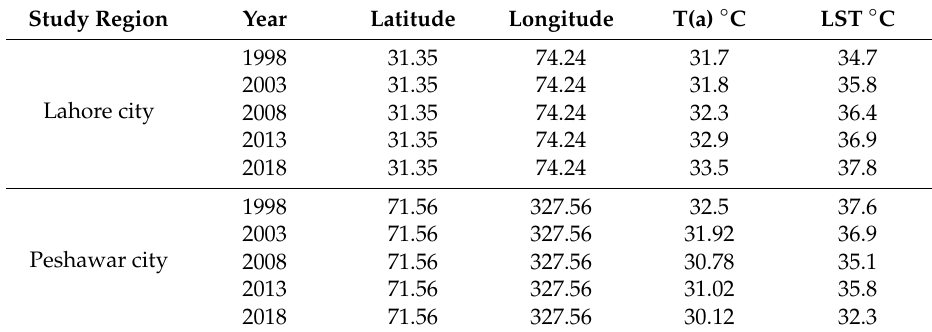
Table 9. Comparison of 3 months (May-July) of mean LST and air temperature T(a) in Lahore (top) and Peshawar (bottom).